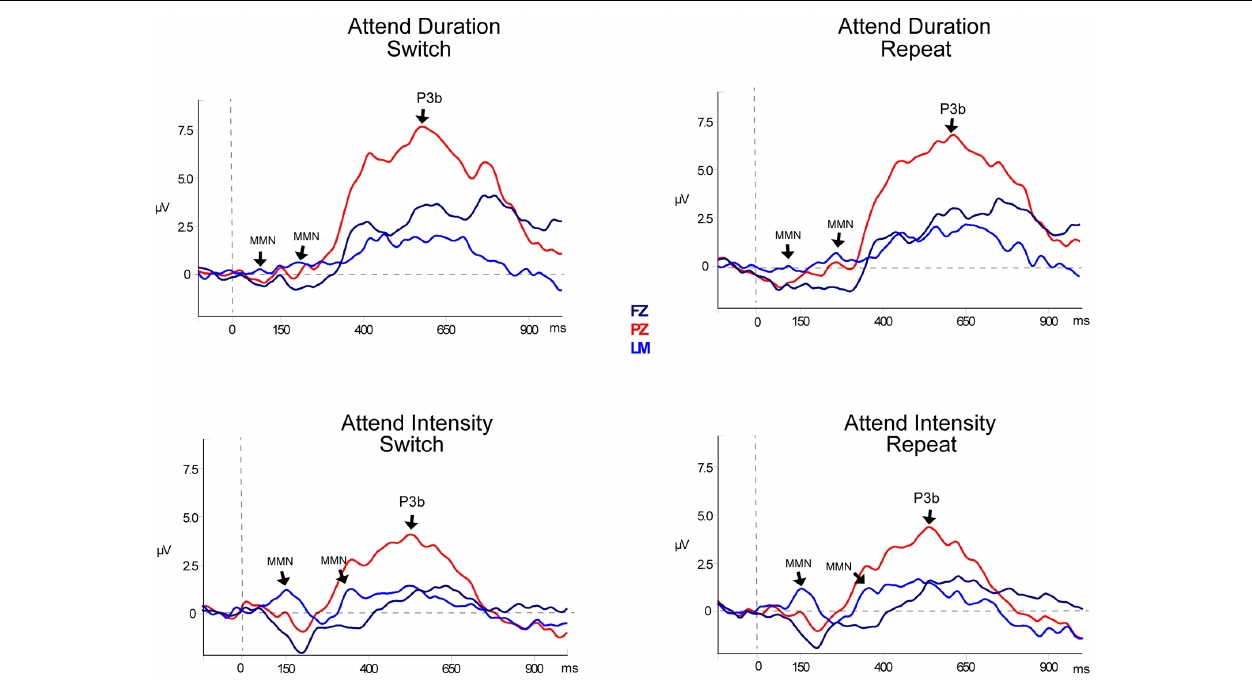
FIGURE 3 | Event-related potentials for target pattern deviants. Difference waveforms (deviant-minus-standard) are displayed for duration (top row) and intensity (bottom row) targets. Responses to the target during Switch trials are shown in the left column and responses to the targets during Repeat trials are shown in the right column. Responses recorded from Fz (dark blue solid line), the left mastoid (LM; light blue solid line), and Pz (red solid line) are overlain to demarcate both the mismatch negativity component (MMN) response and the P3b components. Significant components are denoted with an arrow and labeled. Two successive MMNs were elicited by two successive tones within the pattern